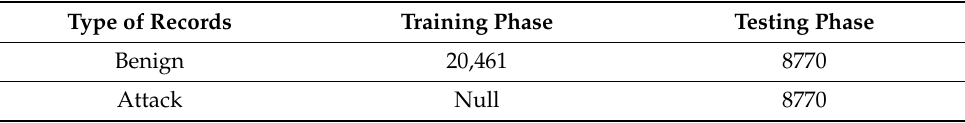
Table 2. The Number of Records in the Training and Testing Phase.